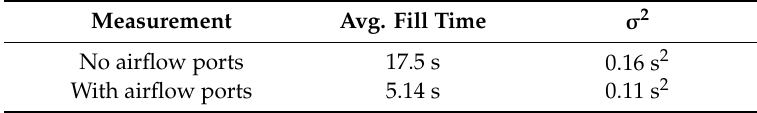
Figure 7. Sample collection probe: ( a ) prototype sample collector build, attached to the electromagnetic valve locking it into the support device. ( b ) CAD design of the probe, with detail of the filling ports, airflow exits, and the buoyancy lock valve. ( c ) Rendering of a UAV landed on a delivery station, with a sample retrieval cabinet. Table 1. Experimental results with and without airflow exit